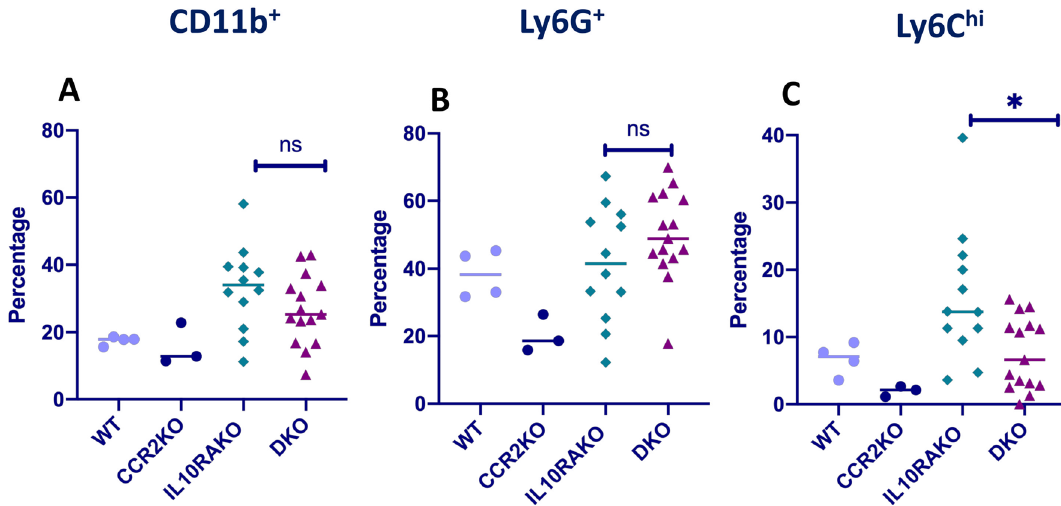
Figure 3. Decreased circulating Ly6C hi monocytes in IL10RA-deficient mice lacking CCR2. The percentages of ( A ) CD11b + cells within the CD45 + gate, ( B ) Ly6G + , and ( C ) Ly6C hi cells within the CD11b + gate of circulating blood cells isolated from WT (n = 4), CCR2KO (n = 3), IL10RAKO (n = 12) and DKO (n = 15) mice, as determined by flow